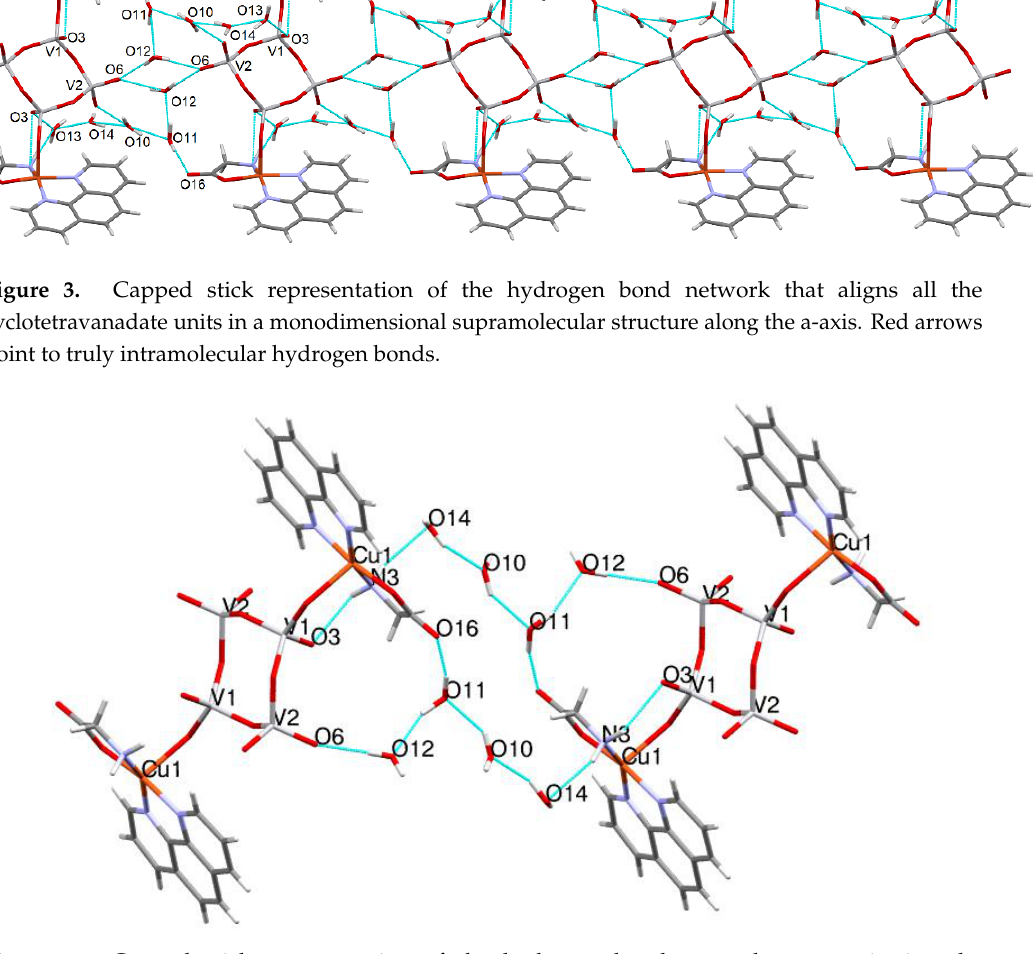
Figure 4. Capped stick representation of the hydrogen bond network communicating the cyclotetravandates in the c direction.